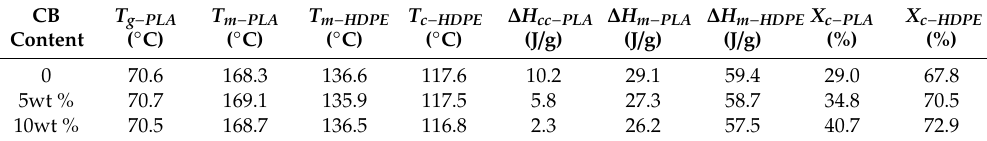
Figure 5. ( a ) Melting and ( b ) cooling curves of PLA70/30HDPE/CB with different CB loadings. Table 2. The thermal parameters of PLA70/30HDPE/CB with different CB loadings from differential scanning calorimeter (DSC).